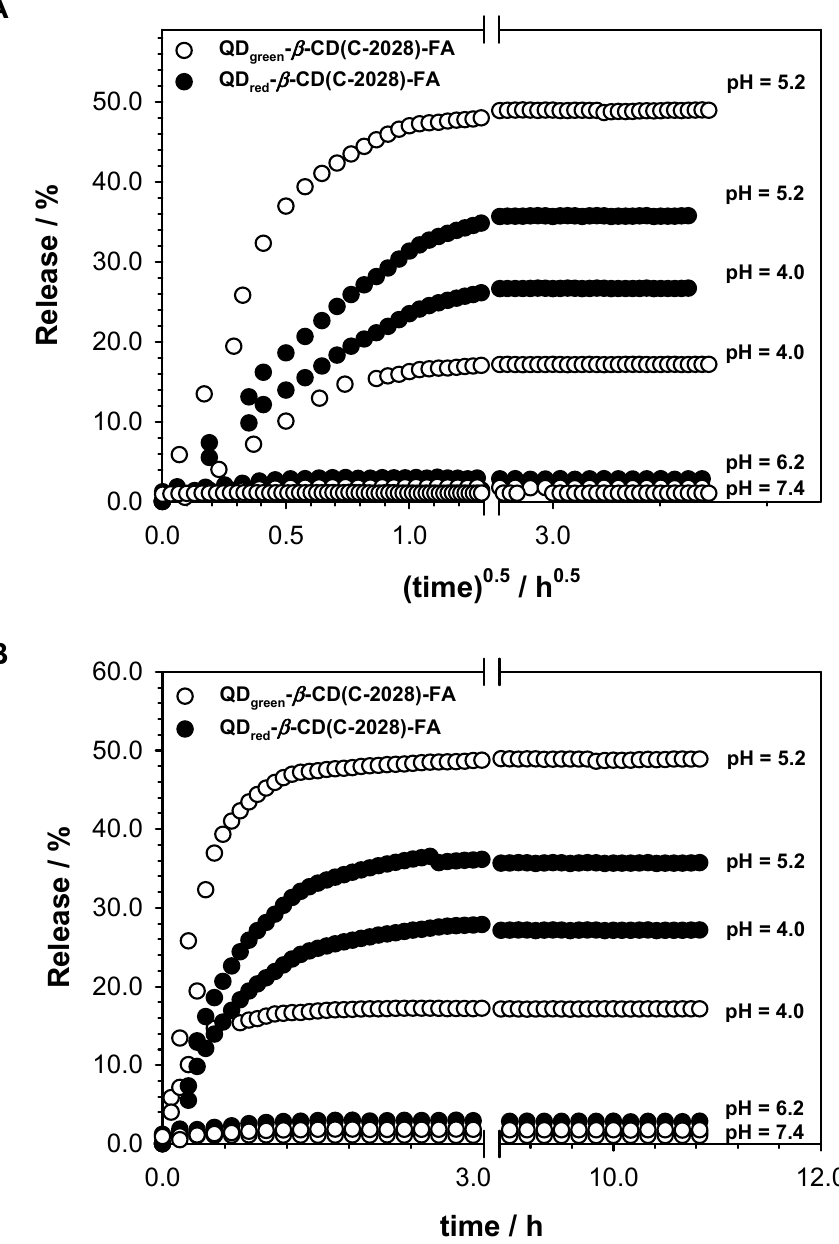
Figure 4. The in vitro release profiles of C-2028 from QDs- β -CD(C-2028)-FA nanoconjugates in four media differ in pH (pH: 7.2, 6.2, 5.2, and 4.0) according to Higuchi ( A ), and Korsmeyer–Peppas ( B ) models. Table 1. Change in coefficient regression ( r ), release rate constant ( k H ), and release exponent ( n ) for the studied QDs- β -CD(C-2028)-FA nanoconjugates.